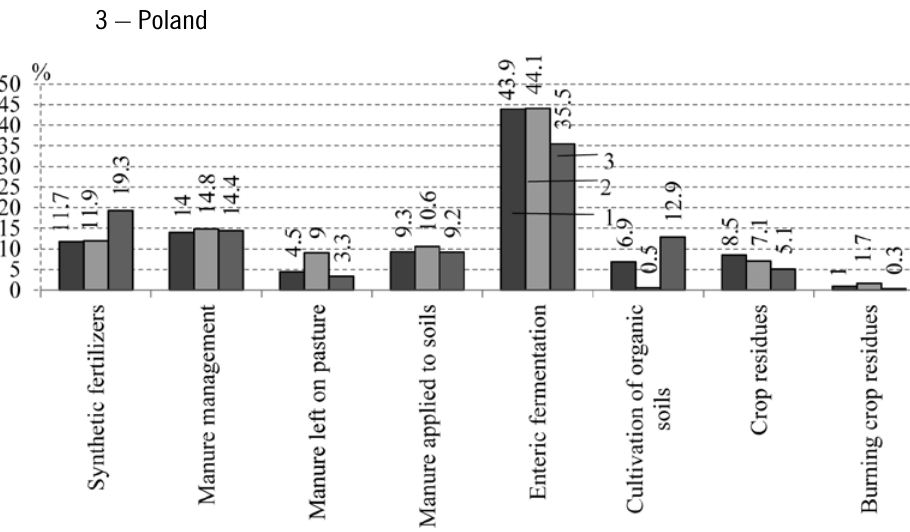
Figure 3. GHG emissions by agricultural activity, 1990–2017: 1 – Ukraine; 2 –